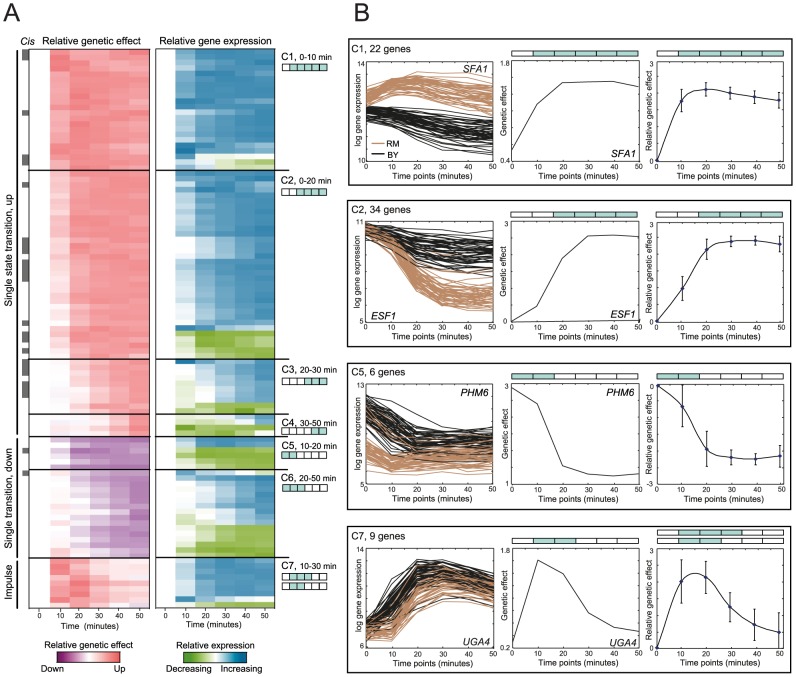
A catalogue of dynamic, non-linear genetic effects in gene response following rapamycin treatment in yeast.(A) Genetic effect profiles (left) and gene expression profiles (right) at six time points following rapamycin treatment (columns) for all genes identified by DyVER. Genetic effect values are the average increase (red) or decrease (purple) in effect size relative to non-stimulated cells (log-scaled). Gene expression values are the average increase (blue) or decrease (green) in gene expression relative to non-stimulated cells (log-scaled). Cis-associated genes are marked in gray (left color bar). Genes are partitioned into seven groups (C1–C7) based on their temporal two-state model (two state cartoons, shown as Fig. 2c, right; four singleton genes are omitted). (B) Four temporal two-state model groups C1, C2, C5, C7 (top to bottom). Left and middle panels: representative genes in each group. Left: gene expression of a representative gene (y-axis, log-scaled) across time points (x-axis). Each curve represents a different segregant, color coded by the best genetic variant found using DyVER (BY/black, RM/brown). Middle: genetic effect profiles of the representative gene, averaged across strains (log-scaled, y-axis) at each time point (x-axis). Right: shown are mean genetic effects (relative to non-stimulated cells, log-scaled; y-axis) and standard deviation (error bars) across time points (x-axis) for a certain group of genes.